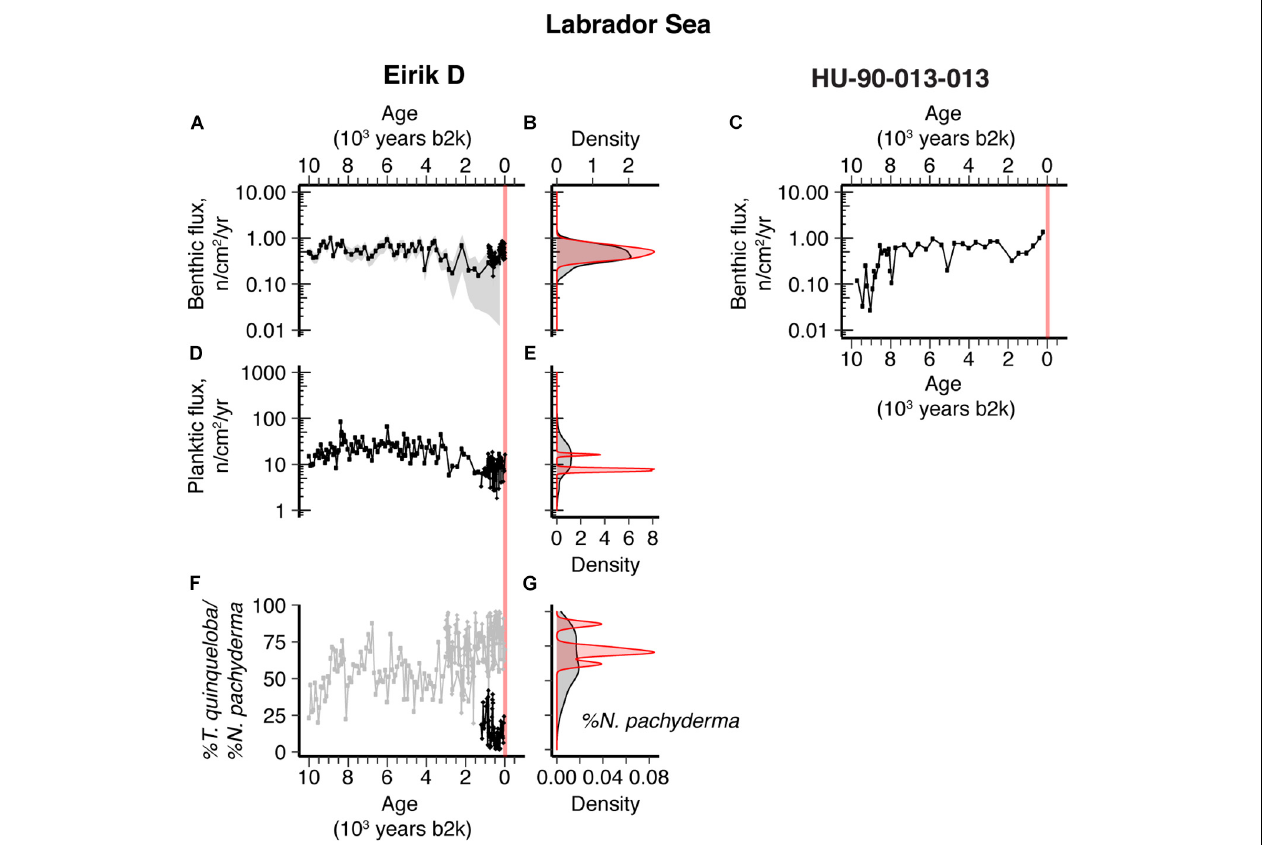
FIGURE 4 | Ten thousand–year Labrador Sea sediment records and density distribution plots comparing the distribution of Holocene (black) versus industrial era (red) data from Eirik D (A,C,E) and HU-90-013-013 (Bilodeau et al., 1994). (A–C) Benthic foraminifera flux; (D,E) planktic foraminifera flux; (F,G) Turborotalita quinqueloba % abundance (black, panel F only) and Neogloboquadrina pachyderma % abundance (gray). Vertical red-shaded band indicates industrial era. Gray-shading in the benthic flux time series plots represents 2 σ